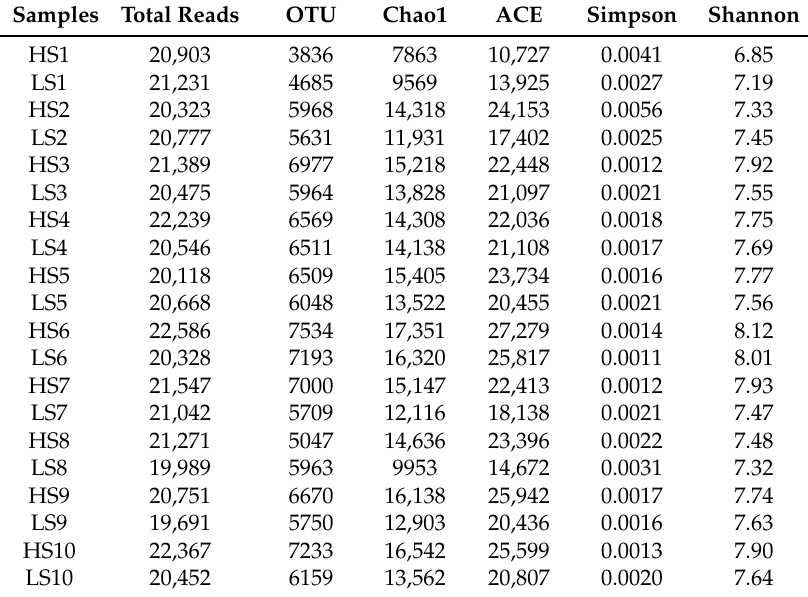
Table 2. Diversity of the 16S rRNA gene libraries from the sequencing